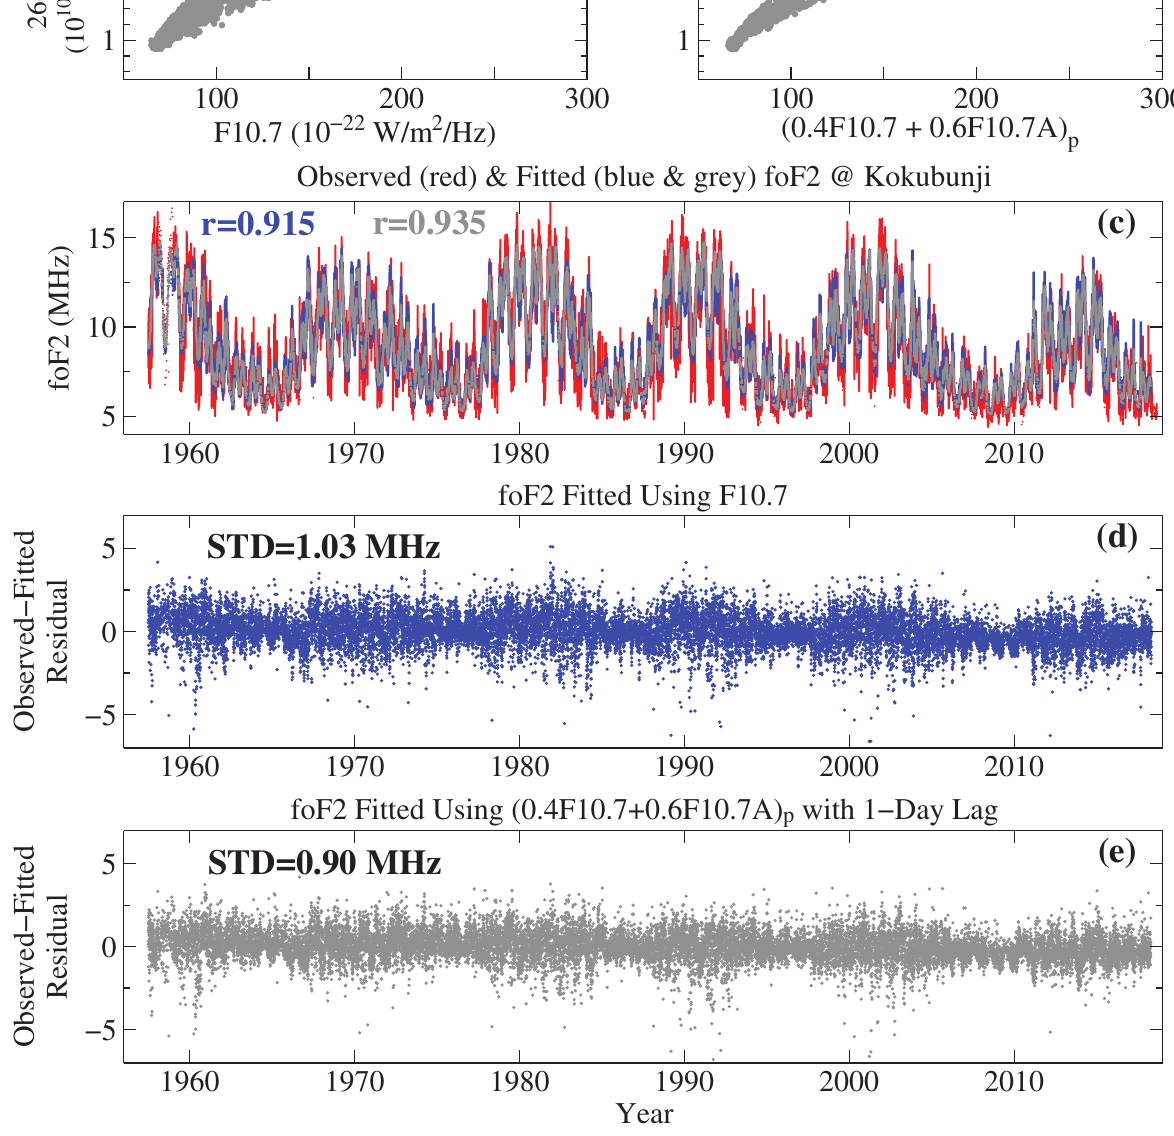
Fig. 2. Scatter plots of daily SOHO/SEM 26-34 nm EUV fl ux versus (a) the F 10.7 index and versus (b) the S index during the solar cycle 23; the parameter r is the correlation coef fi cient between the EUV fl ux and the indices. (c) Variations of mean midday f o F 2 at Kokubunji; the red line for observed values, the blue line for F 10.7 fi tted values, and the grey line for the S index fi tted values with 1 – day lag of f o F 2 to S being included; r is the correlation coef fi cient between observed and fi tted f o F 2 . (d) Difference between observed and F 10.7 fi tted f o F 2 ; the parameter STD is the standard deviation of the difference. (e) Same as Figure 2d but for the S index fi tted f o F 2